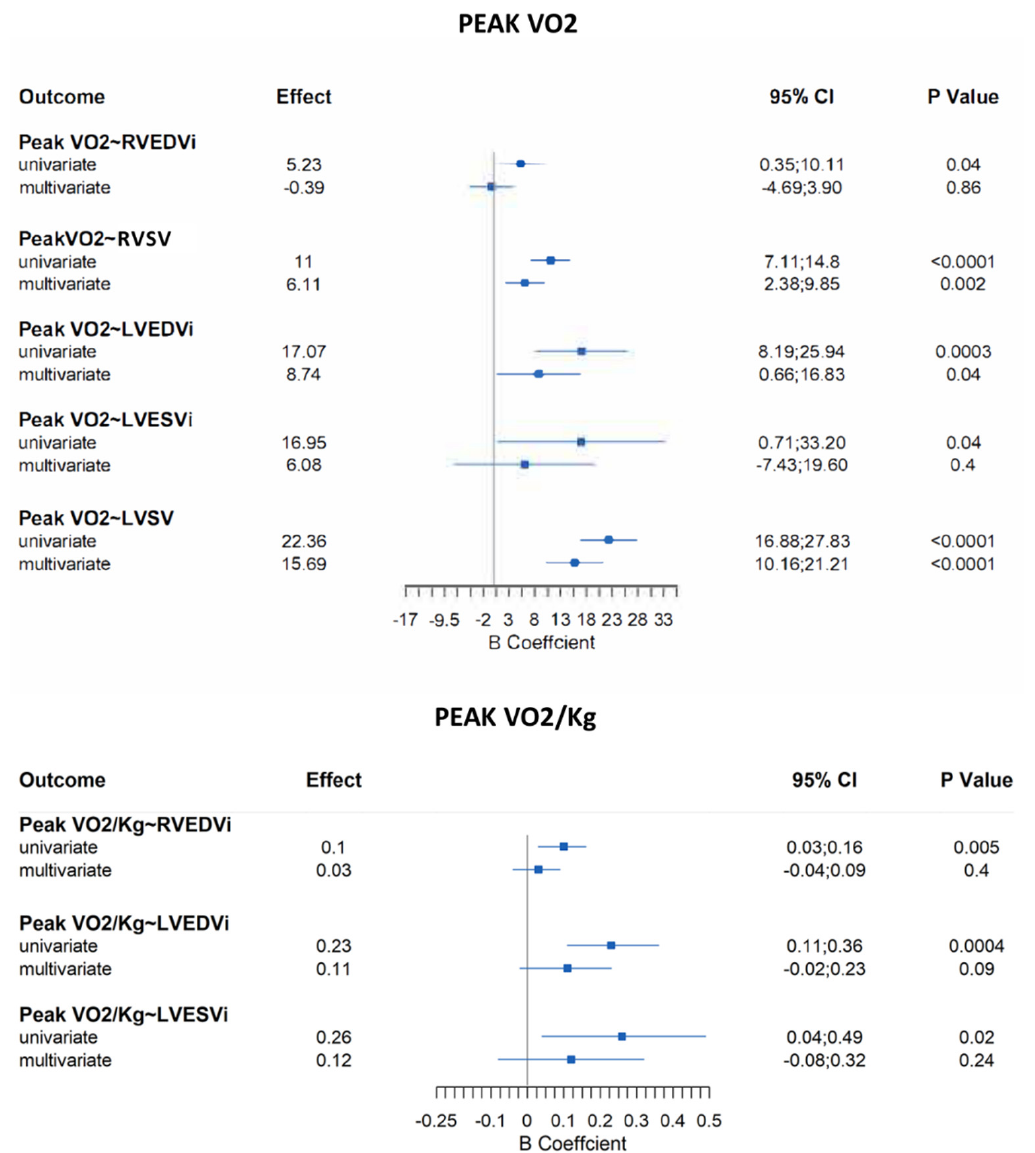
Figure 2. Peak VO 2 and peak VO 2 /kg coefficients from univariate and confounder adjusted multi- variate regression models (only the statistically significant values are reported in this figure. The other results are in the supplemental materials). Legend: LVEDVi: left ventricular end-diastolic volume indexed to body surface area; LVESVi: left ventricular end-systolic volume indexed to body surface area; LVSV: left ventricular stroke volume; RVEDVi: right ventricular end-diastolic volume indexed to body surface area; RVSV: right ventricular stroke